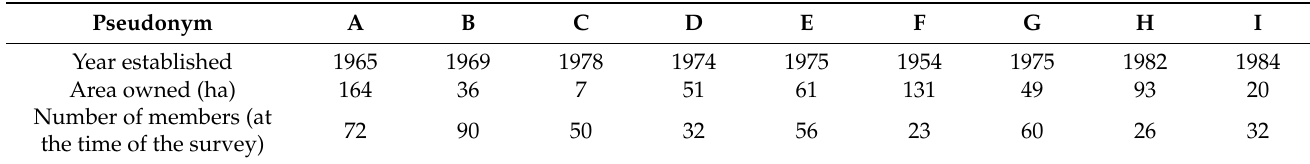
Table 1. Basic information for the FPCs